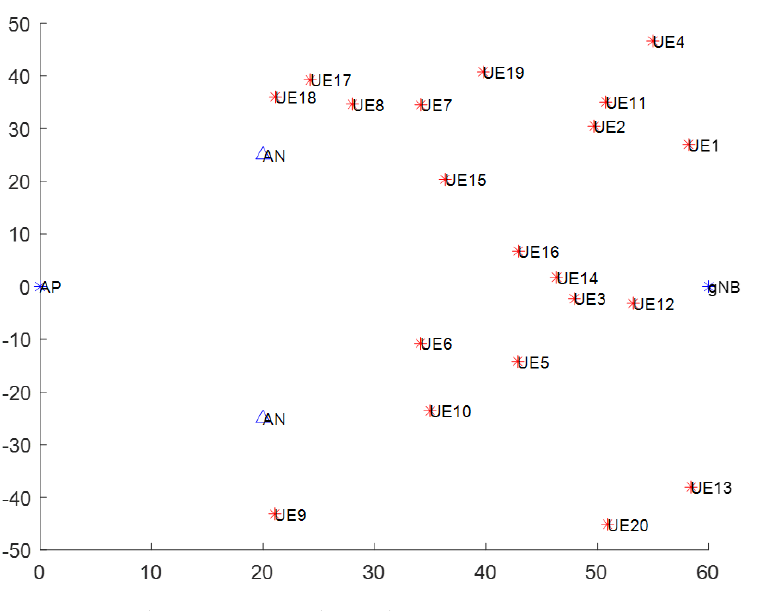
Figure 4. Simulation scene coordinate